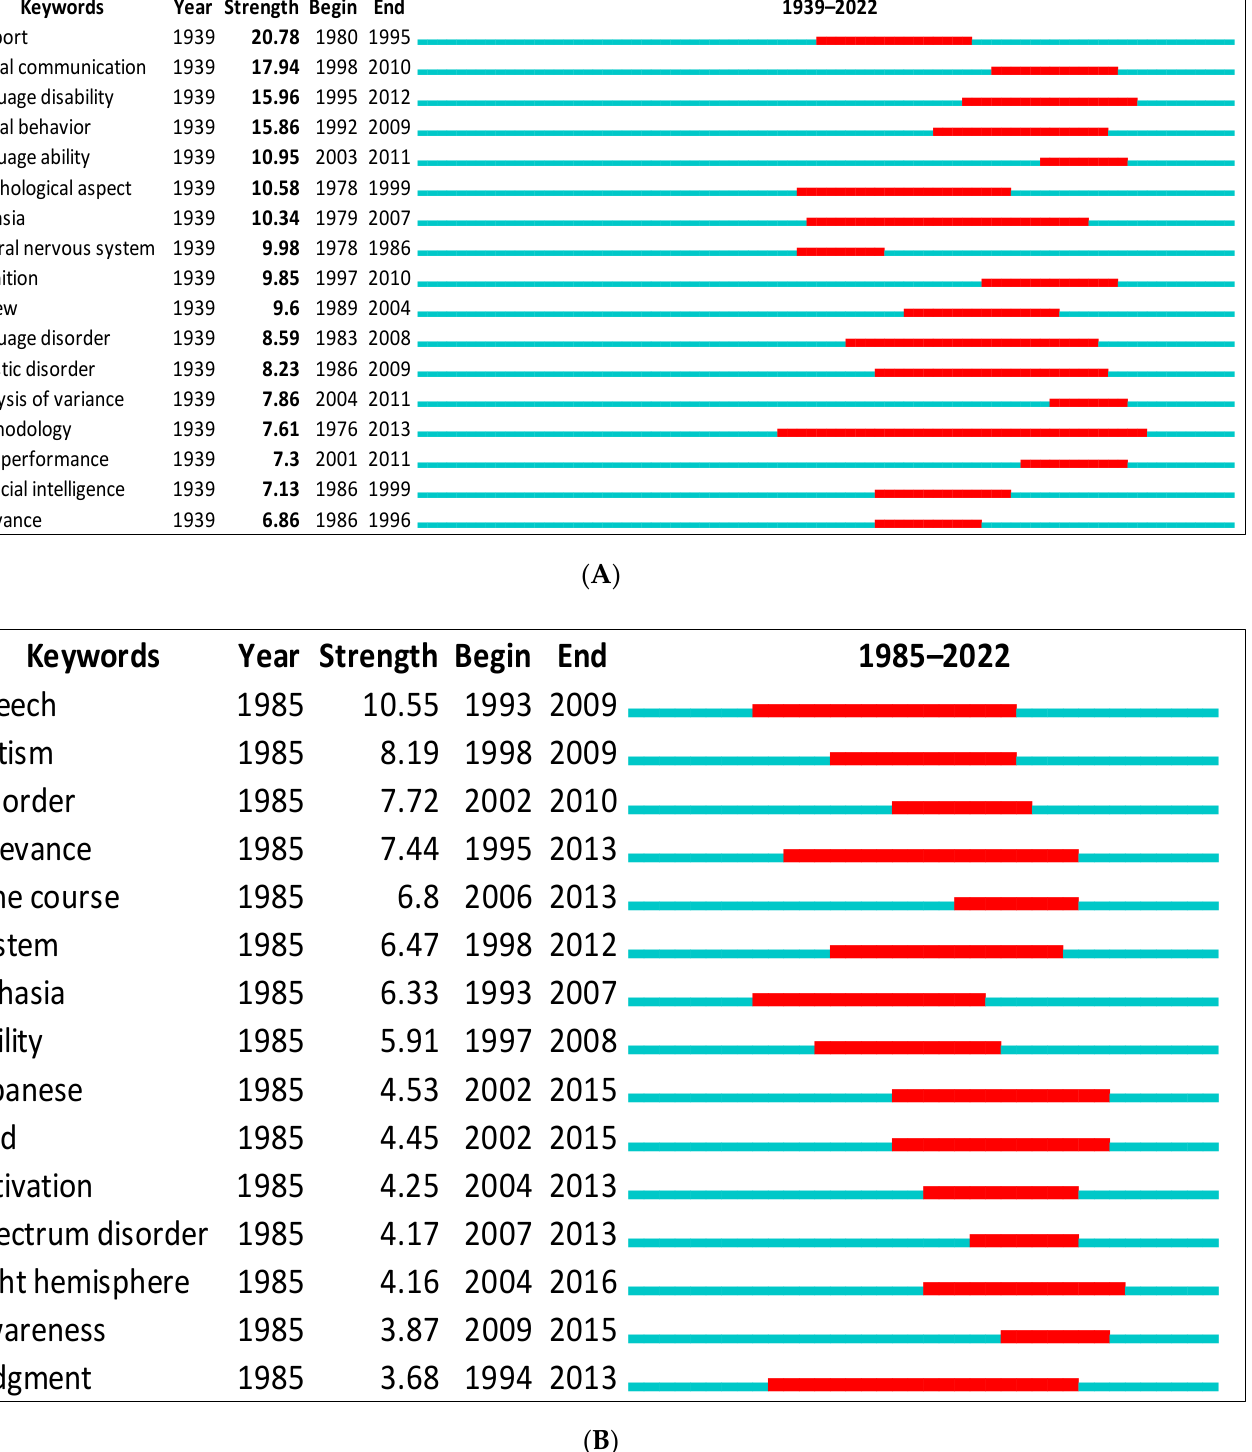
Figure 8. Top keywords with the strongest citation bursts. ( A ) Scopus. ( B ) WOS.